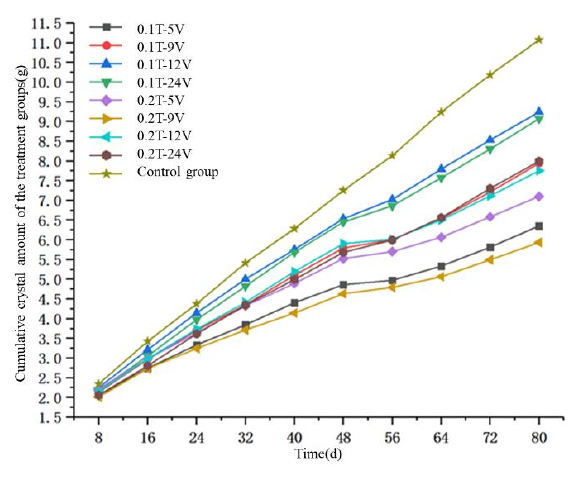
Fig. 9. Changes of the number of cumulative crystalline matter of the treatment groups under electric and magnetic fields over time.